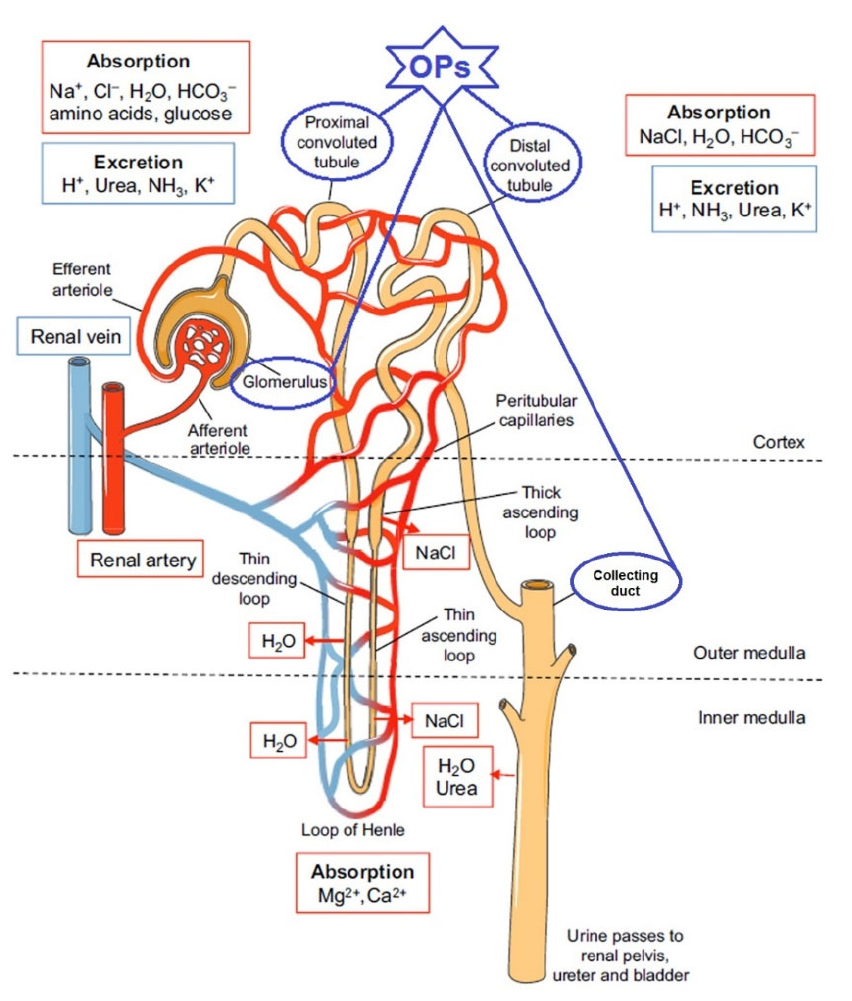
Figure 1. Schematic of a nephron. This schematic shows a nephron, the functional unit of the kidney. The most vulnerable elements of the nephron for OPs are shown in oval frames. Blood is delivered to the glomerulus, where plasma is filtered into the lumen of the tubule. Various ions are excreted and absorbed, and water is retrieved, as plasma passes through the different segments of the tubule, which are intimately linked to peritubular capillaries. Concentrated urine is formed by this filtration process, which then passes through the collecting duct to the renal pelvis. The different components of a nephron occupy distinct regions of the kidney: the cortex and outer and inner medulla, as shown (after [44] with additions). Creative Commons Attribution License. AKI is a likely consequence of OPs’ poisoning. A retrospective cohort study published in 2015 of 8924 patients aged over 20 years showed that the overall incidence of AKI was higher than in controls (4.85 versus 3.47/1000 person-years). After adjustment for age, sex, comorbidity, and interaction conditions, patients with OPs poisoning had a 6.17-fold higher risk of AKI compared to the comparison group. Patients with very severe OP poisoning were associated with a significantly increased risk of developing AKI [42].